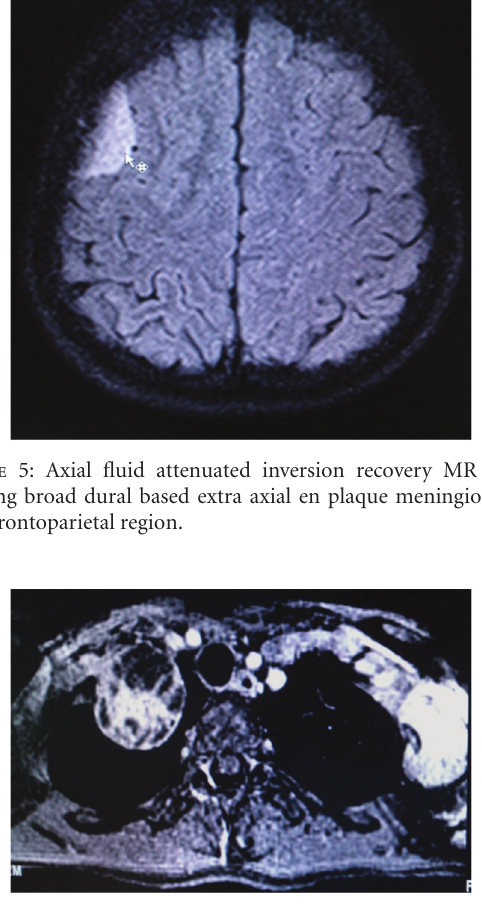
Figure 6: Axial T1 weighted fat saturated postcontrast MR image showing two large extraspinal upper thoracic heterogeneous extraspinal